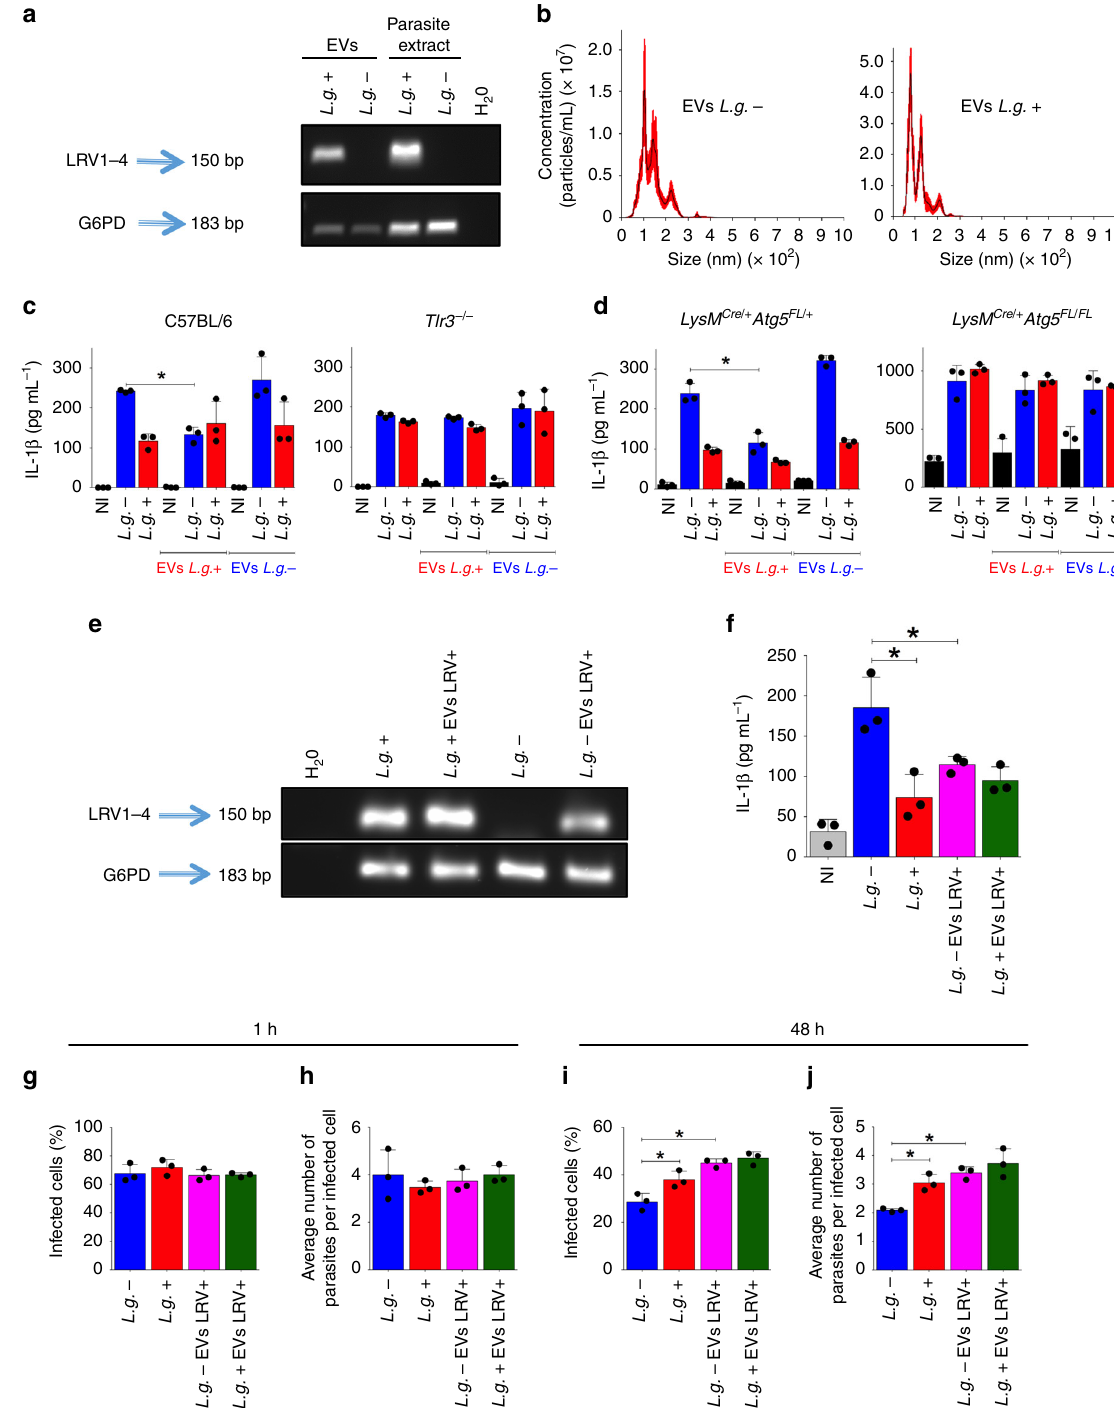
Fig. 7 LRV is shed within EVs and complements L.g. − . a LRV and G6PD were detected by PCR in extracellular vesicles (EVs) puri fi ed from L.g. − and L.g . + (EVs L.g. − and EVs L.g . + ). Parasite extracts ( L.g. − and L.g . + ) and H 2 O were used as PCR controls. b Nanoparticle-tracking analysis of EVs produced by L.g. − and L.g . + . c , d C57BL/6 and Tlr3 − / − ( c ), LysM Cre/ + /Atg5 FL/ + and LysM Cre/ + /Atg5 FL/FL ( d ) BMDMs were primed with LPS and infected with stationary-phase parasites (MOI 10). At the moment of infection, cells were treated with EVs puri fi ed from L.g. − or L.g . + . After 24 h, IL-1 β levels were determined by ELISA in cell-free supernatants. NI: Non-infected. e , f Stationary-phase promastigotes of L.g. − , or L.g . + (used as control), were incubated for 2 h with EVs derived from L.g . + in Schneider ’ s medium ( L.g . + EVs LRV + and L.g. − EVs LRV + ). Parasites were isolated for RNA extraction and PCR analysis ( e ) or used for BMDMs infection at MOI 10, to measure IL-1 β production ( f ). g – j C57BL/6 macrophages were infected with L.g. − or L.g . + (incubated or not with EVs from LRV + ) at MOI 5 for replication assay. After 1 ( g , h ) or 48 h (i , j ), the percentage of infected cells and the average number of parasites per cell were estimated. The results are shown as mean ± SD and statistical analysis was performed by unpaired Student ’ s t test. P < 0.05 (*) was considered statistically signi fi cant. One representative of at least two independent experiments performed with technical replicates is